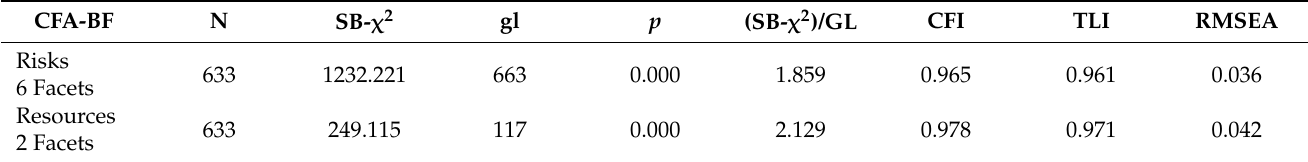
Table 2. Indicators of fit of the confirmatory bifactor analysis of the FER-R.